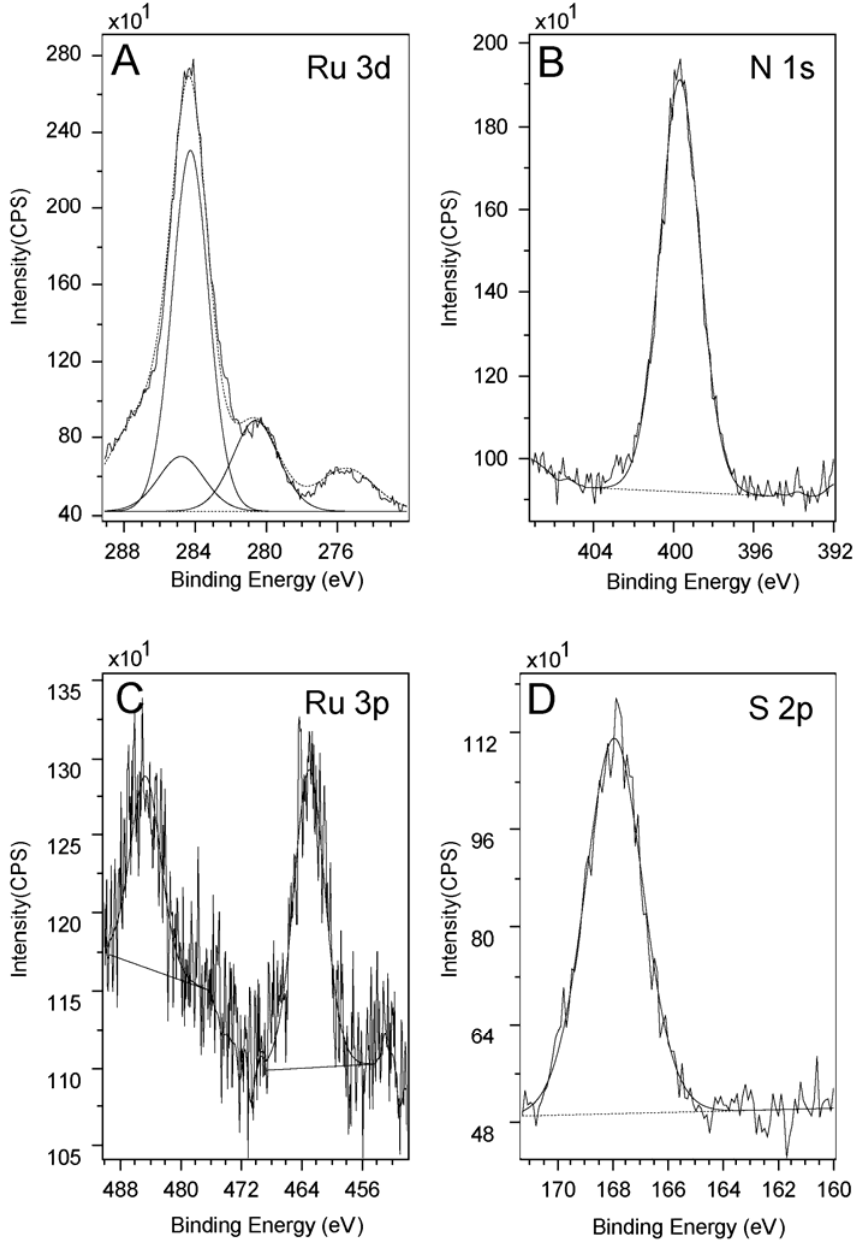
counter ions. Shown in (A), (B), (C), and (D) are the XPS regions corresponding to element components of Ru 3d, N 1s, Ru 3p and S 2p,